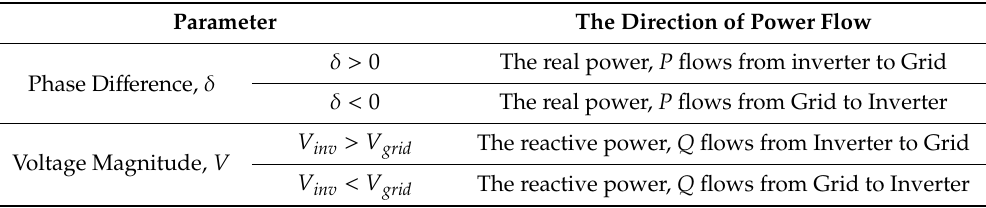
Table 4. Direction of Power Flow [78–80].